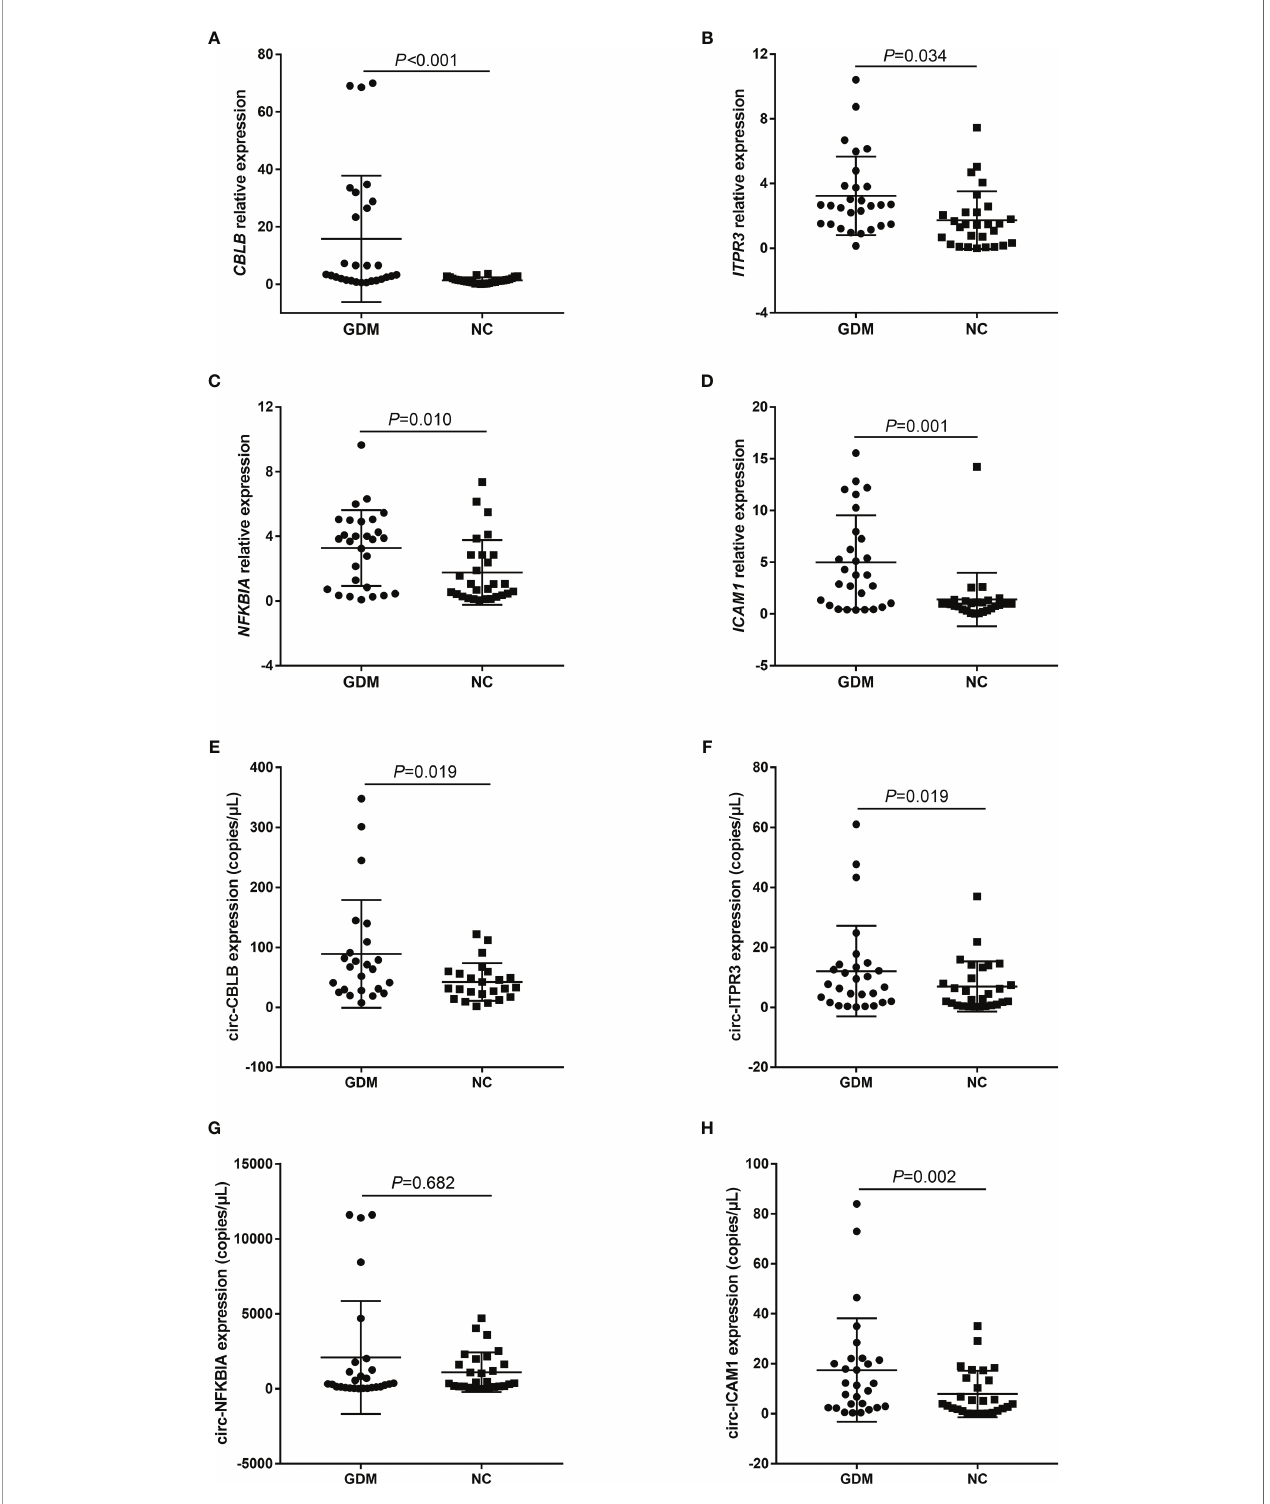
FIGURE 3 | Microarray data were validated by qRT-PCR and ddPCR. (A – H) represent the expression distribution of CBLB, ITPR3, NFKBIA, and ICAM1 and their corresponding candidate circRNAs, circ-CBLB, circ-ITPR3, circ-NFKBIA, and circ-ICAM1, in different samples of the GDM group and control group, respectively. NC, Normal